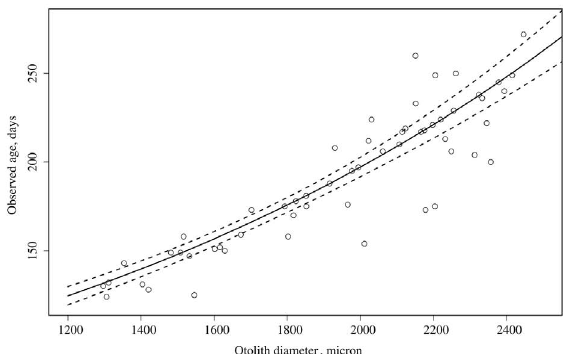
Fig. 2. – Relationship between age and otolith diameter for juvenile sardines in the TsS sample. Solid line, back-transformed age pre- dicted by the regression on otolith diameter; dashed lines, predicted age ±2 se; symbols, observed values.